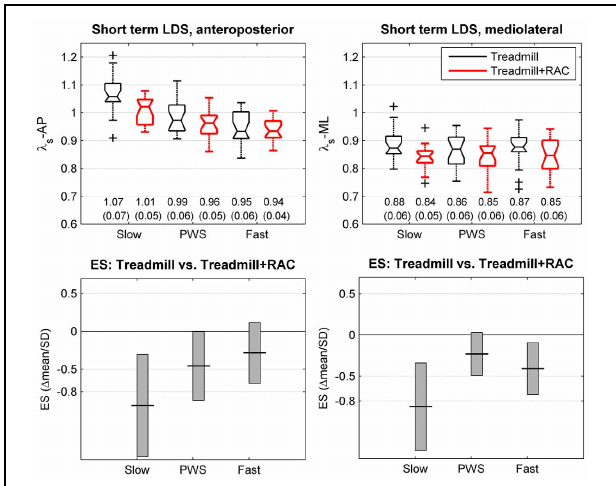
FIGURE 3 | Short-term local dynamic stability (LDS). Twenty healthy subjects walked 3 × 5min on an instrumented treadmill without (thin lines, black) and with Rhythmic Auditory Cueing [RAC, (metronome), thick lines, red] at their preferred cadence for the given speed. The center of pressure trajectory over 175 consecutive strides was analyzed along the anteroposterior and mediolateral axes. Short-term LDS is computed from the rate of logarithmic divergence over one step (finite time Lyapunov exponents, λ S ). Selected speeds were Preferred Walking Speed (middle, PWS), 0.7 × PWS (left, Slow) and 1.3 × PWS (right, Fast). The range of individual results ( N = 20) is presented with notched boxplots. + signs represent outliers. Printed values are mean (SD). Bottom panels show the effect size (ES) of the auditory cueing [i.e., the mean difference normalized by SD (Hedges’s g)]. Vertical boxes are the 95% confidence intervals for the effect size